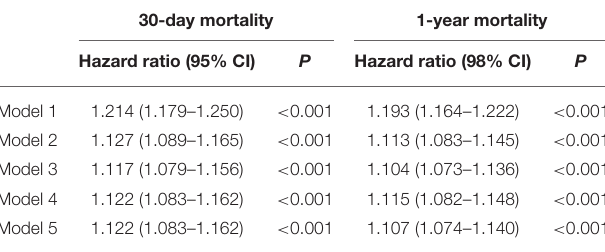
TABLE 2 | Hazard ratio and 95% CI of HR fluctuation (continuous) for